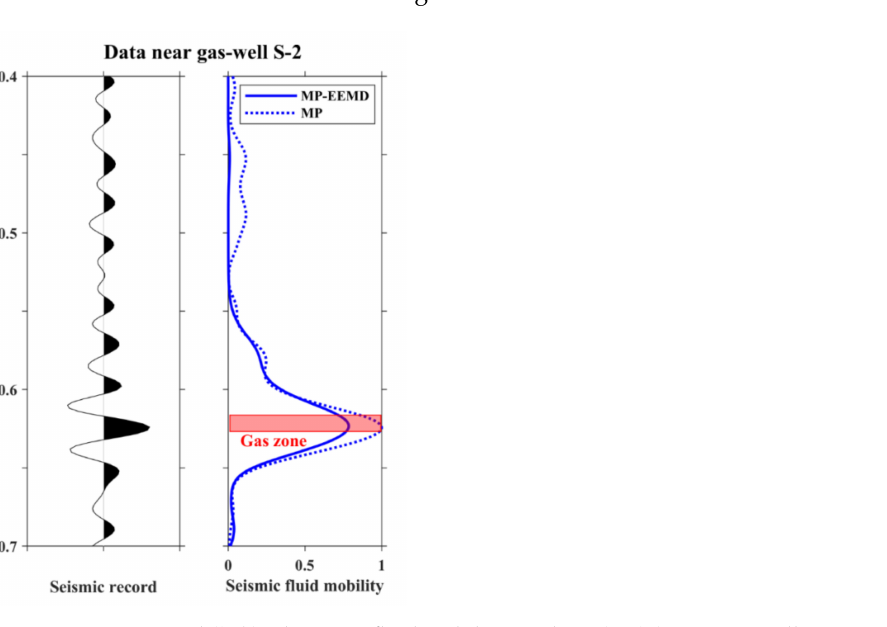
Figure 7. Seismic record ( left ) ad seismic fluid mobility attribute ( right ) near gas well S-2. According to the results of well-seismic calibration, the gas zone in well S-2 (depth 906–922.2 m) is located at time 0.617–0.625 s (red rectangle).